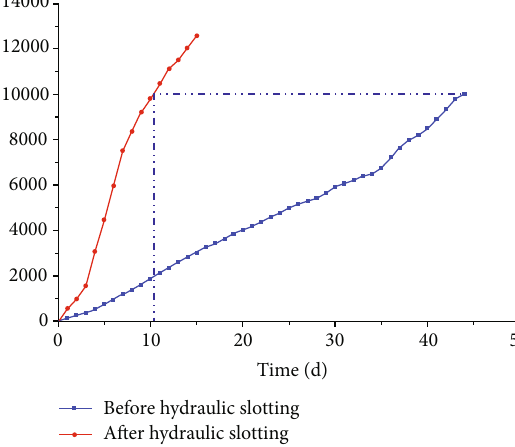
Figure 8: Total quantity of gas extraction vs. time.